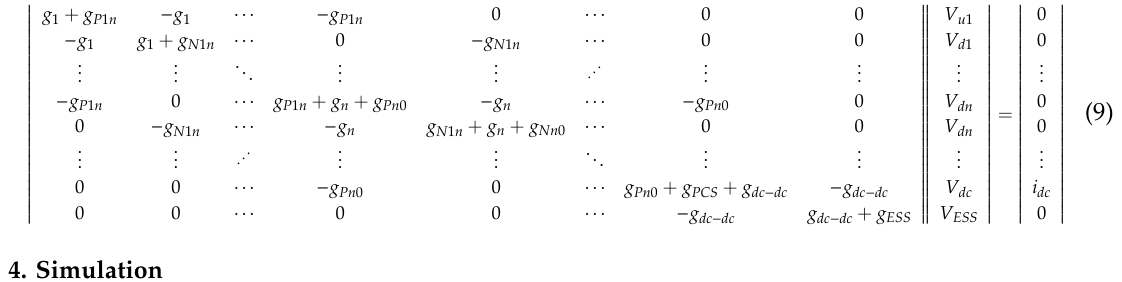
Figure 4. Modified control diagram of iterative method.